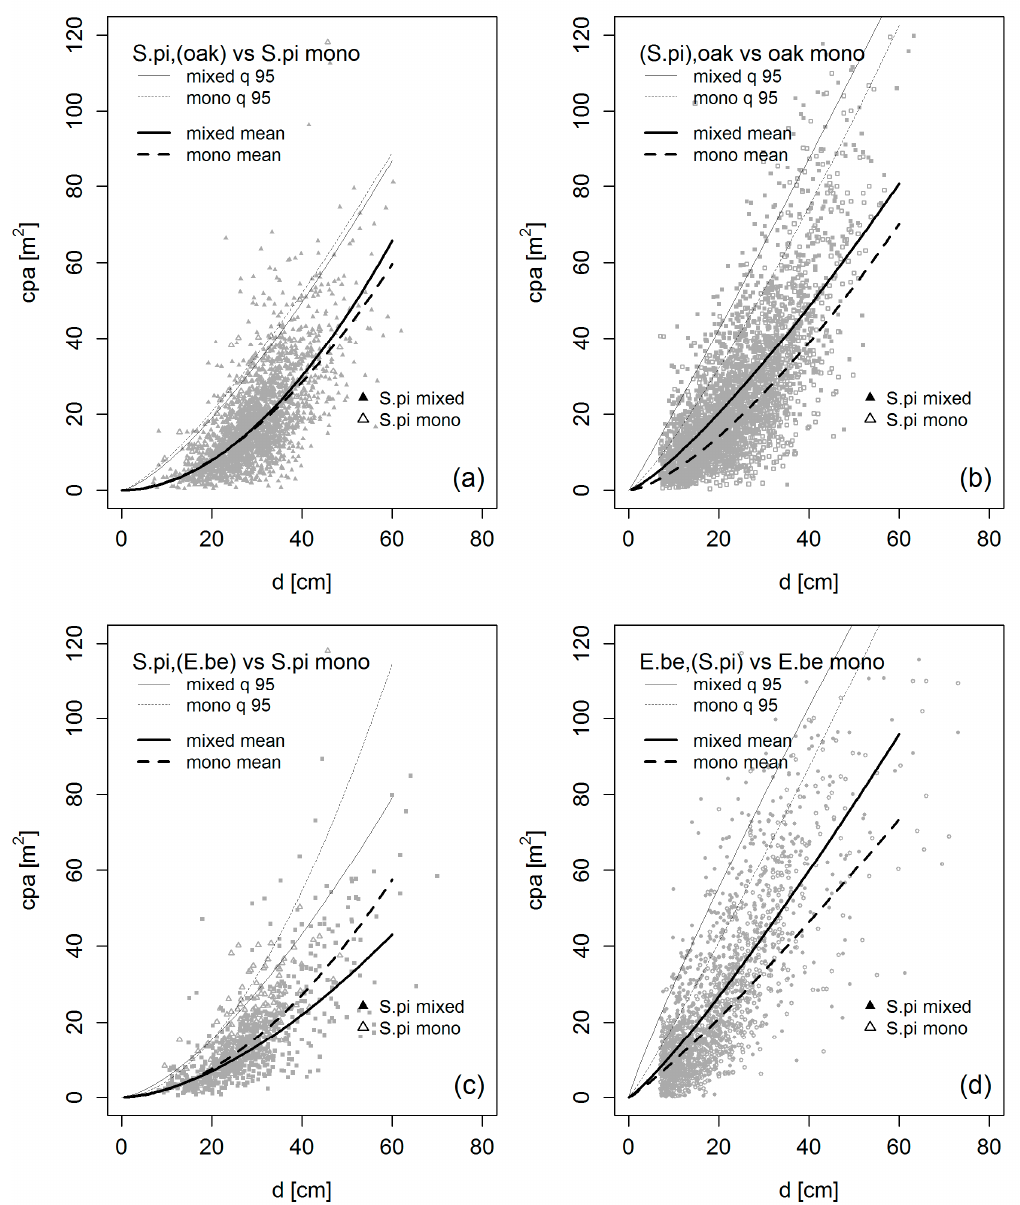
Figure 11. Crown projection area plotted over stem diameter in mixed-species versus monospecific stands of ( a , b ) Scots pine and sessile/common oak, and ( c , d ) Scots pine and European beech. The curves were based on the mean (solid lines) and 95% quantile (thin lines) regression analyses of the cpa-d relationship. The analysis was based on crown measurement in monospecific and mixed-species stands across Europe (see model 6 in Table 1).